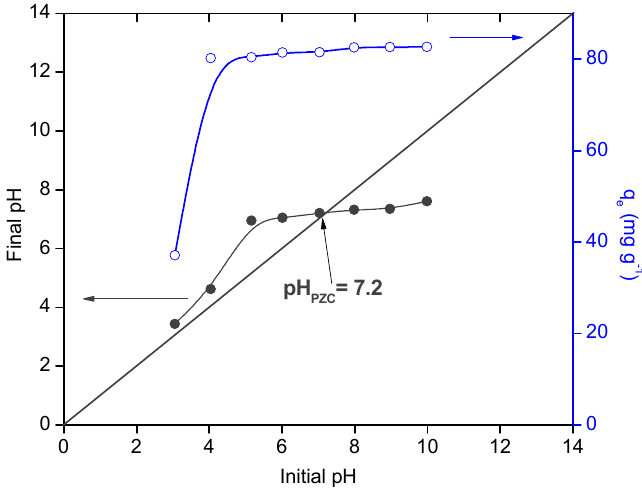
Figure 6. E ff ect of Ph solution on methylene blue (MB) equilibrium adsorption Figure 6. Effect of pH solution on methylene blue (MB) equilibrium adsorption capacity.